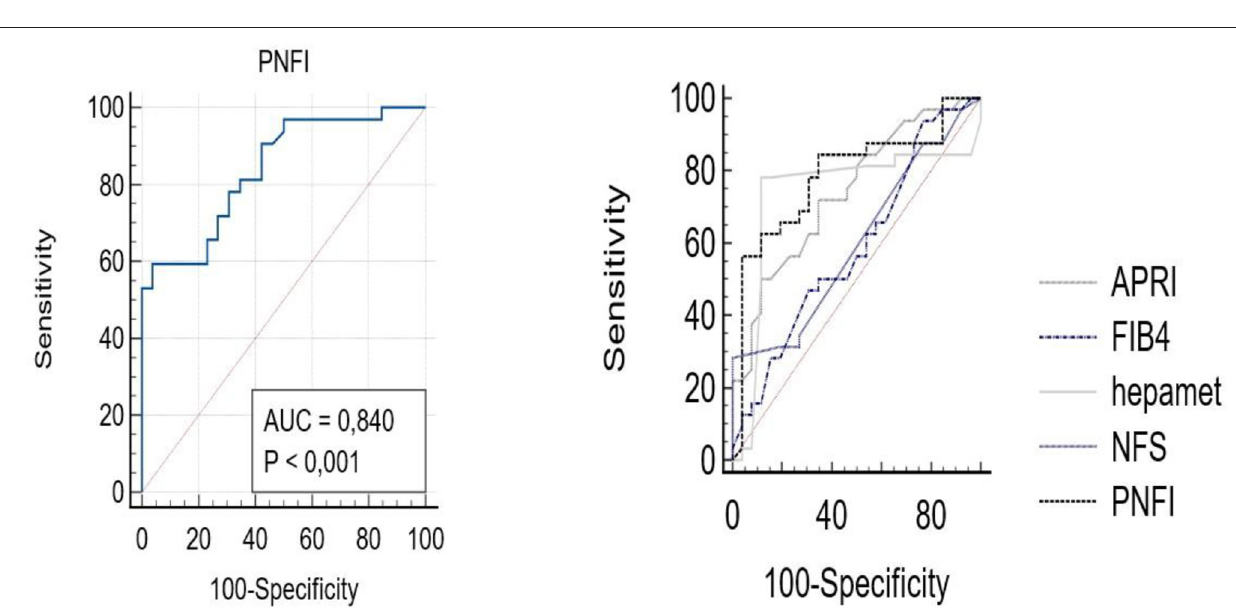
play a role as the pediatric population affected by NAFLD is in most cases related to visceral obesity (70% of cases) and insulin resistance, variables used in this score ( Table 1